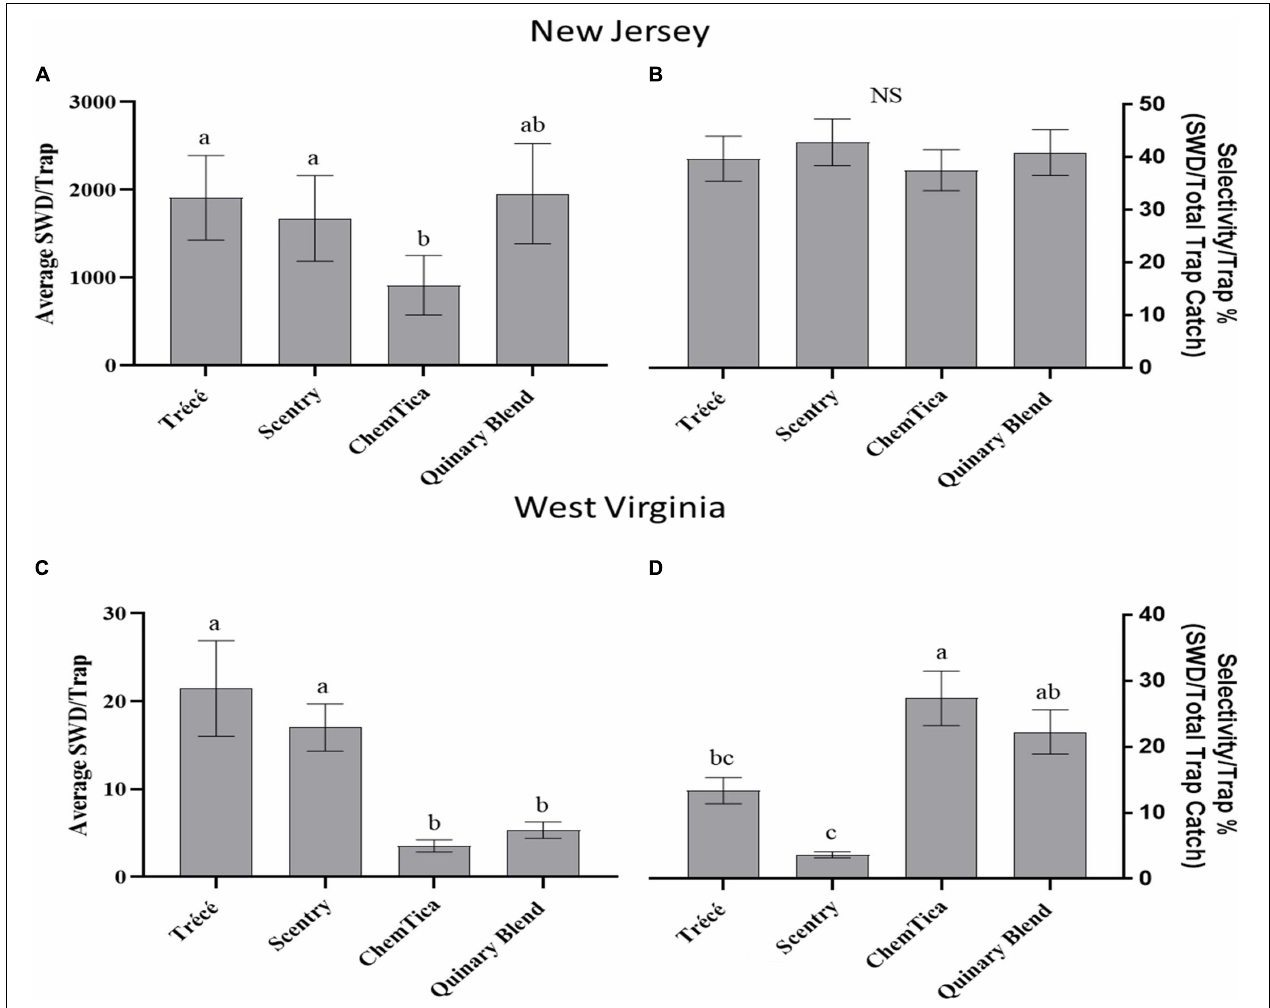
FIGURE 6 | Average SWD catch per trap and selectivity per trap over the entire trapping period in New Jersey in blueberry bushes and West Virginia in a raspberry field in 2018. Traps baited with Trécé dispenser, Scentry dispenser, ChemTica dispenser, and a quinary dispenser. (A) average catch in the blueberry bushes in New Jersey in 2018 ( N = 324, df = 3, 320, F = 4.573, and P = 0.0038); (B) selectivity in the blueberry bushes in 2018 ( N = 317, df = 3, 313, F = 0.3954, and P = 0.7564); (C) average catch in the raspberry field in West Virginia in 2018 ( N = 256, df = 3, 252, F = 10.97, and P < 0.0001); and (D) selectivity in the raspberry field in West Virginia in 2018 ( N = 242, df = 3, 238, F = 10.87, and P < 0.0001). Means separated by One-way ANOVA with a Tukey’s post-test. Error bars represent standard error. Different letters above bars in each subfigure indicate significant differences at α = 0.05. Data represented are